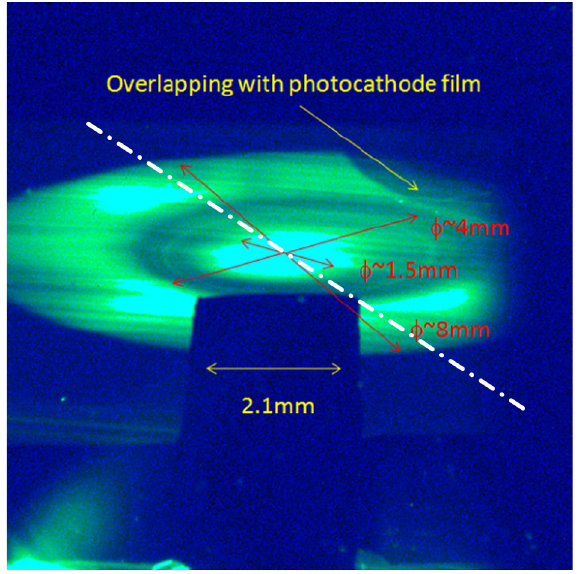
FIG. 9. False color photographs from the XRD CCD camera at various diffraction angles, illustrating the variation in lattice spacing as a function of distance from the central damage spot.